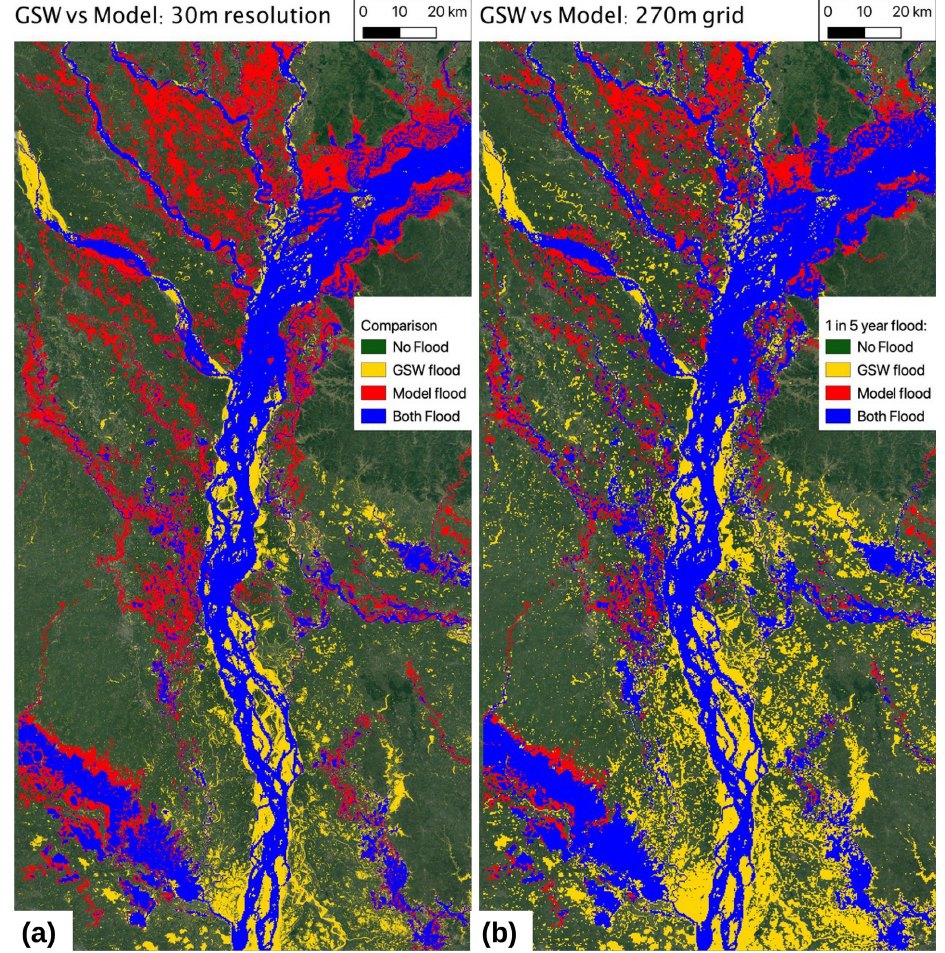
Figure 11. Flood extent comparisons between model and GSW data set. (a) Flood extent of 1 in 5 years (20% recurrence), comparing modeled and GSW flood extent at 30m resolution. (b) As per (a) but at 270m resolution. In (b) , the 270m grid cells for GSW are considered flooded where 10% of higher-resolution cells are flooded. Note: model results show flood inundation greater than 0.5m. Modeled flood recurrence is calculated over the period 1980–2017, with nine simulations run for each year, generated from runoff simulations with differing FUSE configurations. Map data ©Google Earth 2020. Table 4. Modeling inputs and outputs (at daily frequency ∗ ), which are passed between